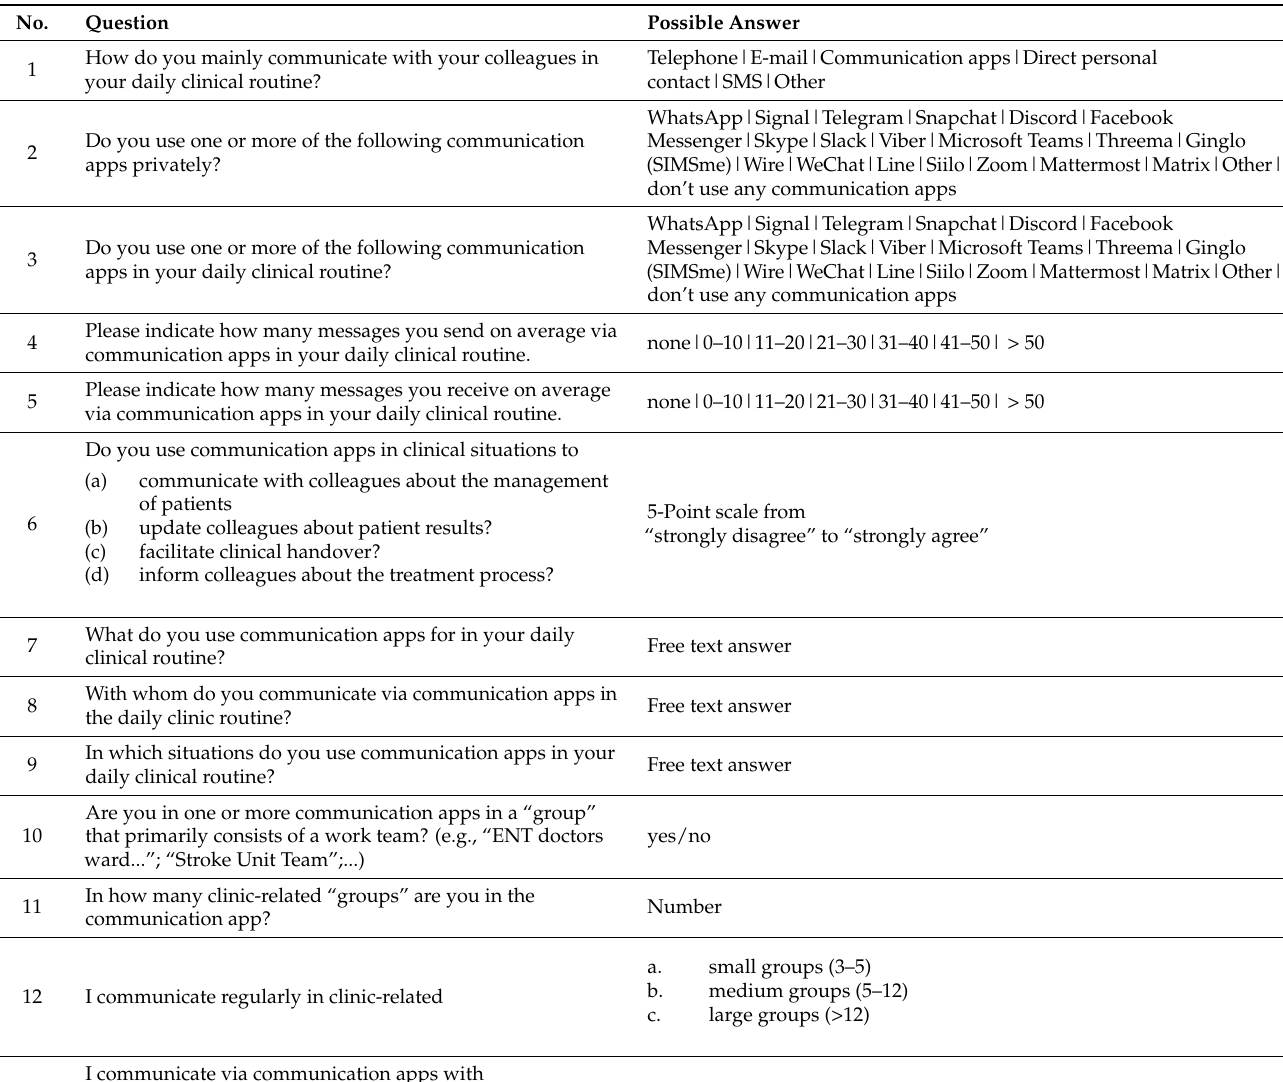
Table A1. Translated questionnaire of the